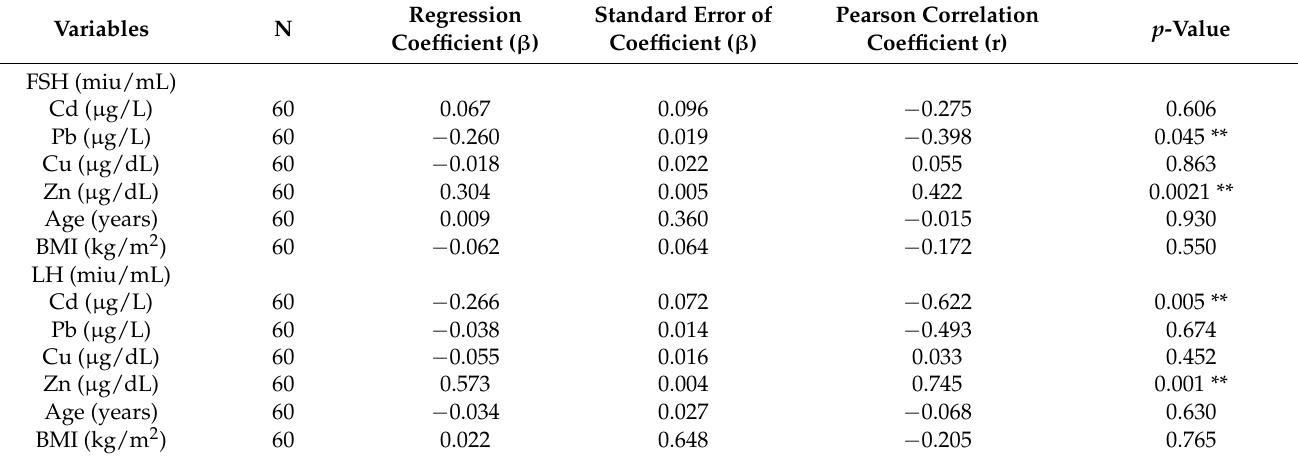
Table 7 shows the interrelationship of FSH and LH with toxic and essential metals, age and BMI of participants. Serum FSH correlated negatively (r= − 0.398; p < 0.001) with Pb, and positively with serum Zn (r = 0.422; p < 0.002). Similarly, LH correlated negatively with Cd (r = − 0.622; p < 0.001) and positively with Zn (r = 0.745; p < 0.001). No signifi- cant correlation was observed between FSH, LH and the other measured variables. The regression coefficient between serum estradiol and other measured parameters indicates that estradiol correlated positively with Zn (r = 0.412; p < 0.003). There was no signifi- cant correlation between serum progesterone and other measured parameters. Similarly, serum prolactin correlated positively with Pb (r = 0.443; p < 0.006) and negatively with Zn (r= − 404; p < 0.047). Lastly, serum testosterone correlated positively with Zn (r = 0.542; p < 0.001) (Tables 8 and 9). Table 7. Interrelationship of sex hormones and other measured